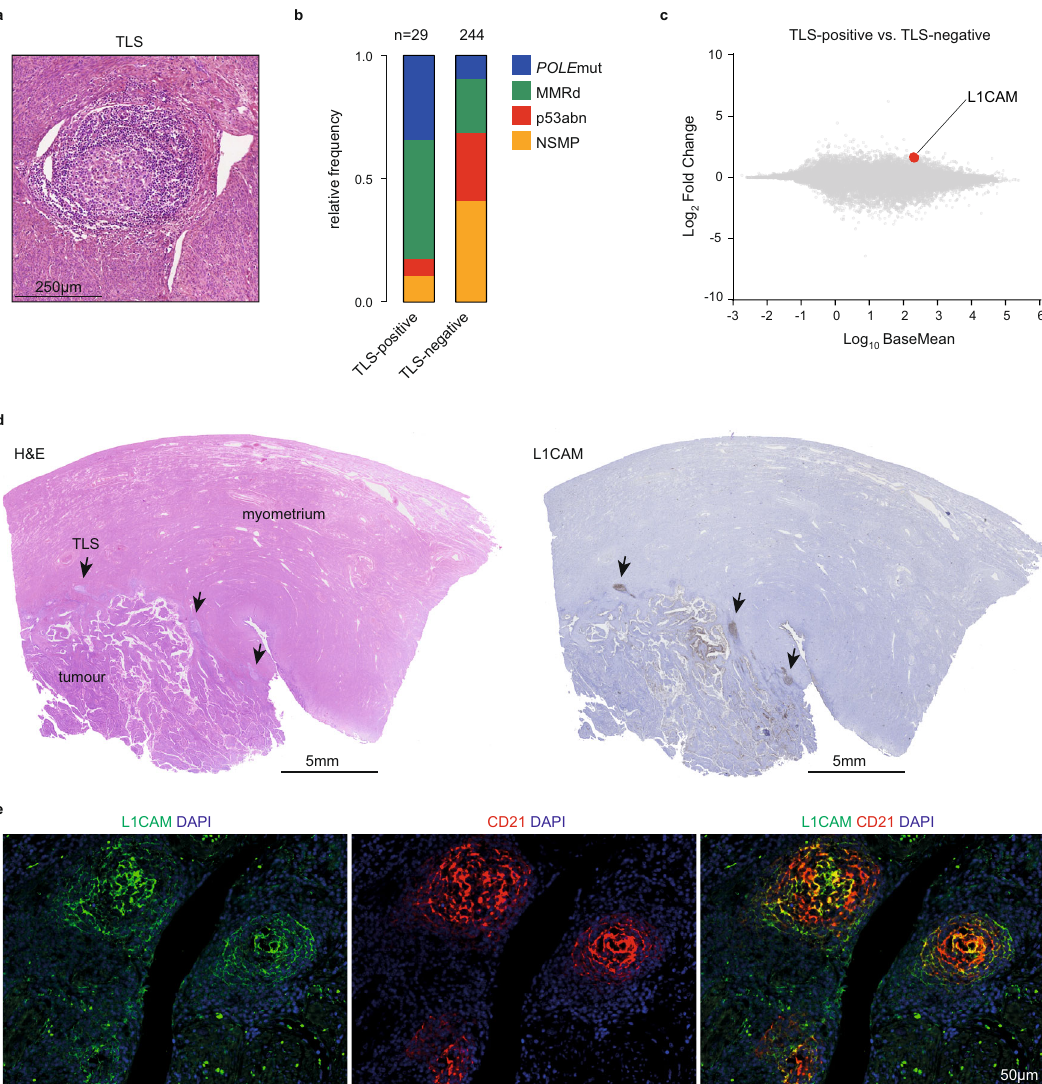
Fig. 2 L1CAM expression in mature germinal centers of tertiary lymphoid structures. a Representative H&E image of a TLS in EC, which were observed in 29 of the 273 cases of the Uterine Corpus Endometrial Carcinoma (UCEC) cohort of The Cancer Genome Atlas (TCGA) research consortium. b Frequency of molecular subgroups by TLS status in endometrial cancer patients included in the UCEC TCGA. Source data are available at: https:// portal.gdc.cancer.gov. c Differential gene expression of TLS-positive versus TLS-negative TCGA UCEC cases. d Representative L1CAM-positive TLS case. Arrows indicate TLS. e Co-immuno fl uorescent analysis of L1CAM-positive TLS with L1CAM and CD21. The experiment was repeated four times with similar results. n Number of cases, POLE mut Pathogenic polymerase epsilon mutation, MMRd Mismatch repair-de fi cient, p53abn p53 abnormal, NSMP No speci fi c molecular pro fi le, TLS Tertiary lymphoid structure, L1CAM Ligant-1 cell adhesion molecule, DAPI 4 ′ ,6-diamidino-2-phenylindole. Source data are provided as a Source Data